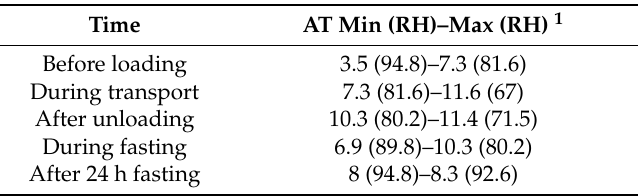
Table 1. Values for climatic variables during the study